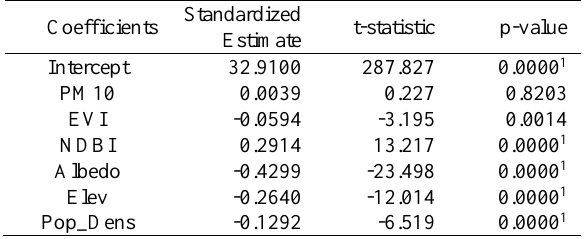
Table 3. Multiple linear regression